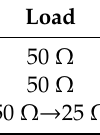
Figure 10. Output voltage responses in Case 2. Figure 11. Inductance current responses in Case 2.